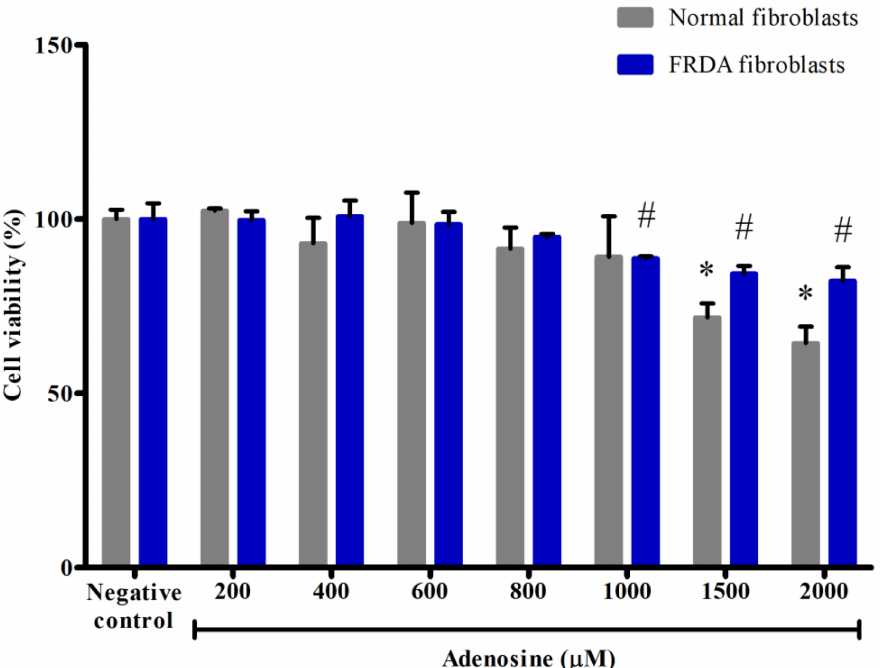
Figure 1. Effects of adenosine on the viability of normal and FRDA fibroblasts. Cell viability was evaluated by MTT assay following incubation with various concentrations of adenosine for 24 h. Data are expressed as mean ± SD and statistically analyzed by one-way ANOVA with Tukey’s post-hoc test. Asterisk (*) and hash sign (#) indicate significant differences ( p < 0.05) in viability for different groups of normal and FRDA fibroblasts, respectively, compared to the negative control